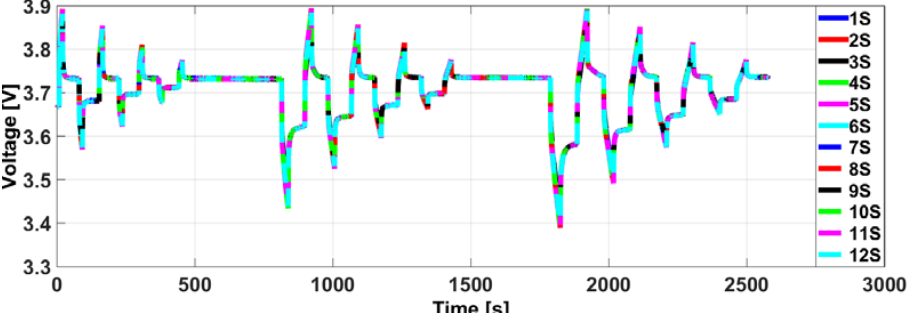
Figure 3. Difference in 12 cell voltages of each representative cell, measured using a voltage sensor, in the fresh battery pack consisting 28 parallel ‐ connected cells according to the discharging/charging current profile for aging (4C ‐ rate).